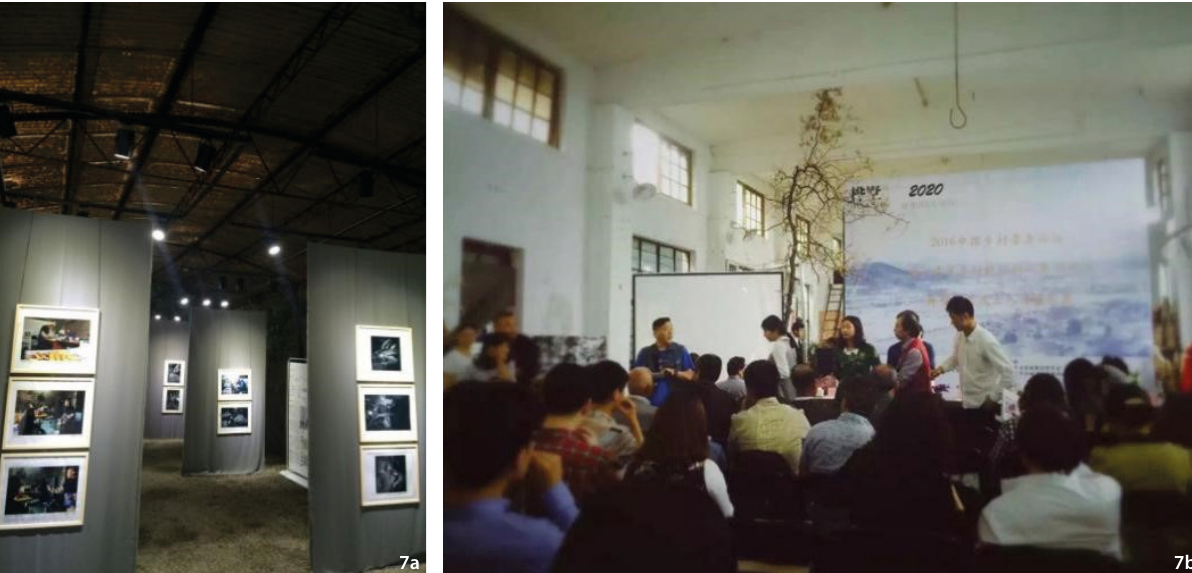
7a Figure 7a and 7b Various exhibitions and events in Sanniaocang (Source: Jun Guo).